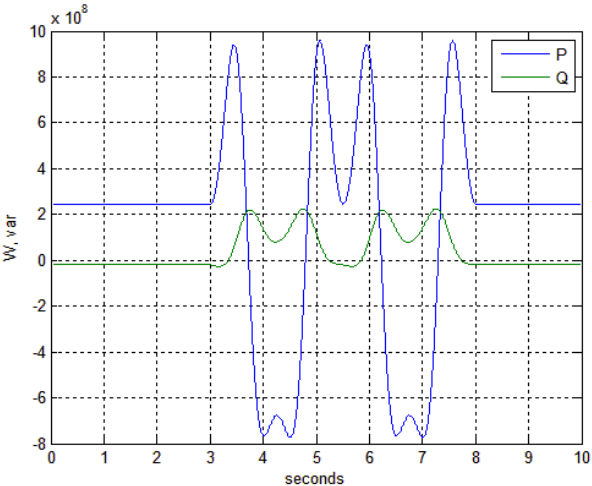
Figure 5. Active and reactive power oscillations on 400 kV transmission line during out-of-step condition in simulations that last 10 s without protection action.